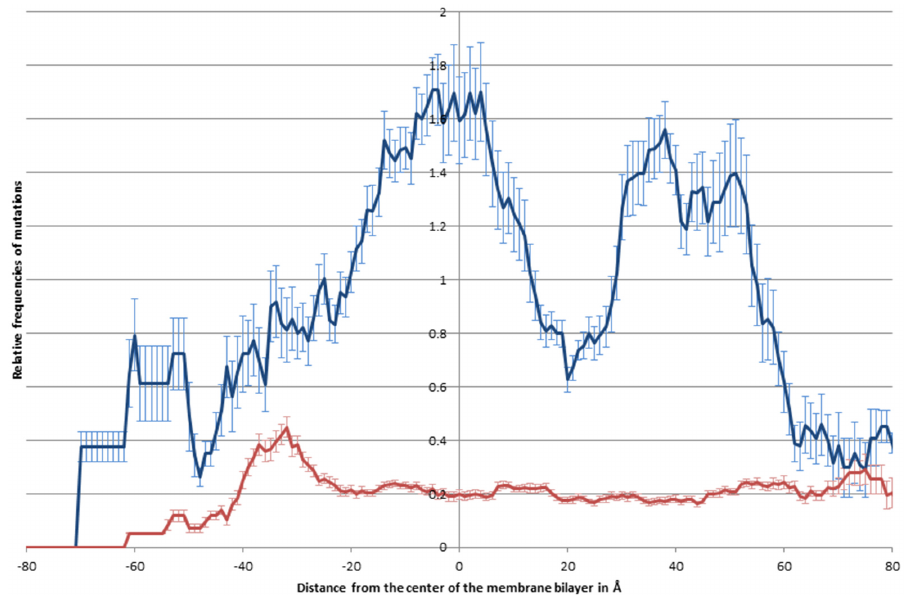
Fig 5. Distribution of relative frequencies of mutations along the z-axis. The relative frequencies of disease causing mutations (blue) and polymorphisms (red) are shown along the z-axis See Materials and Methods for